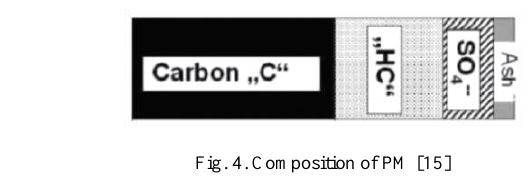
Fig. 4. Composition of PM